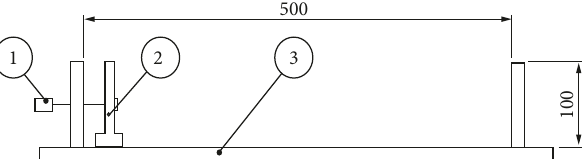
Figure 2: Illustration of the test set-up for early-age shrinkage (all dimensions in mm). Notes:1 represents the part connecting with the laser sensor. 2 represents the part embedded in concrete. 3 represents the